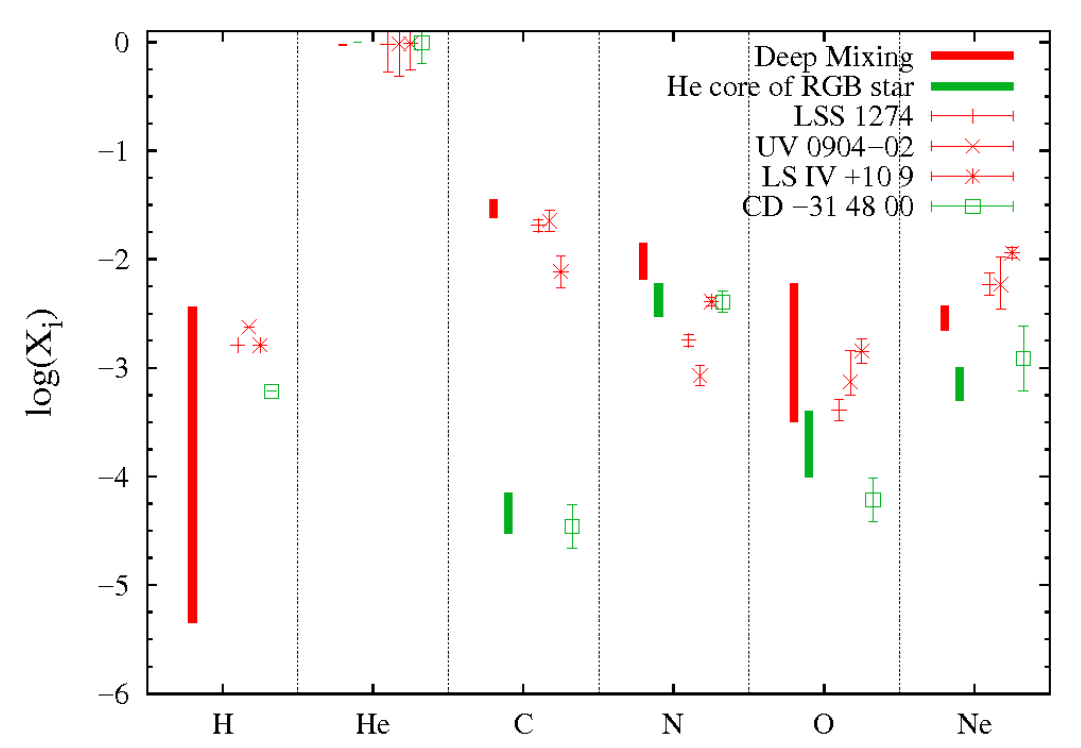
Figure 7. Abundance predictions from deep-mixing hot flasher (Battich) and slow merger models